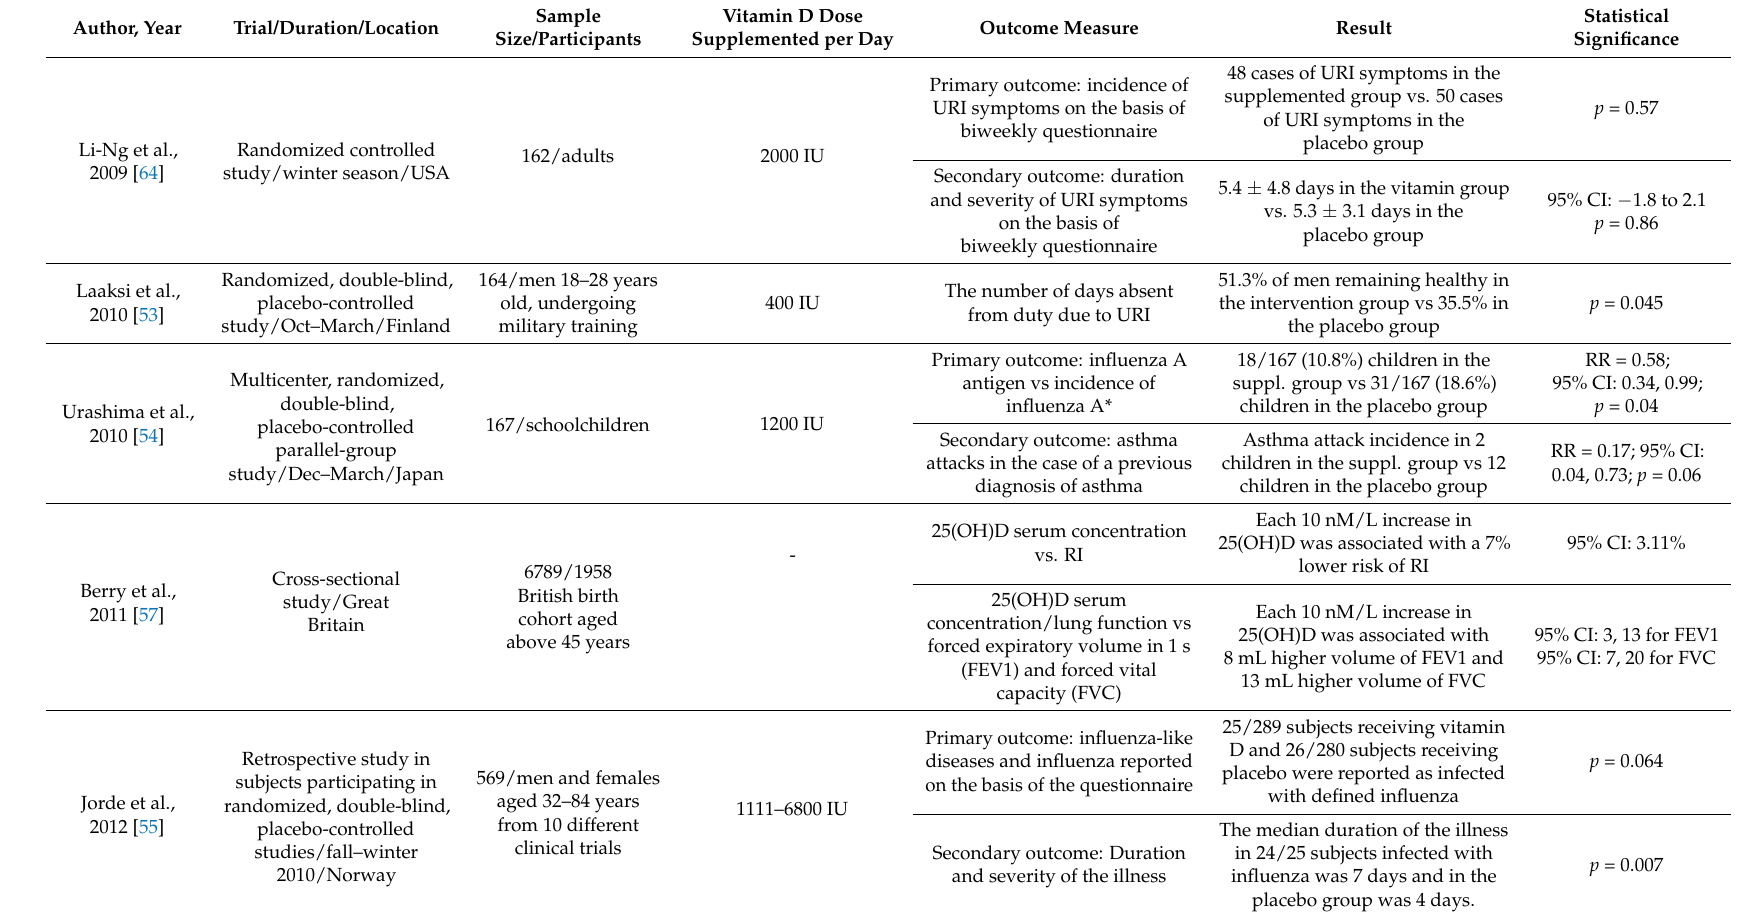
Table 1. The selective human studies on the effect of vitamin D supplementation on influenza, upper respiratory tract infections (URI or RI), and pneumonia incidence published between the years 2009 and